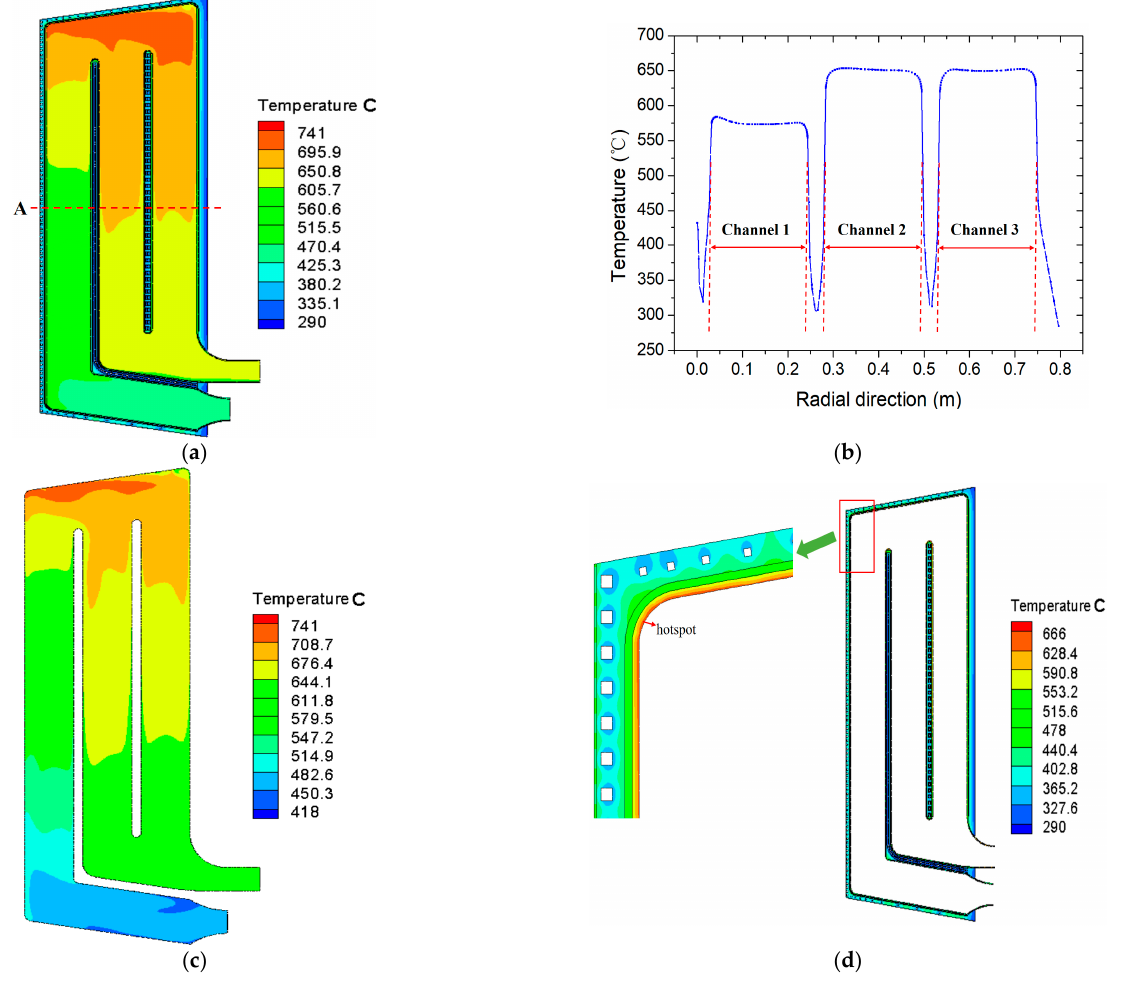
Figure 6. Temperature contour ( a ) entire model; ( b ) radial temperature distribution; ( c ) PbLi; ( d ) FW, gap and SiC.